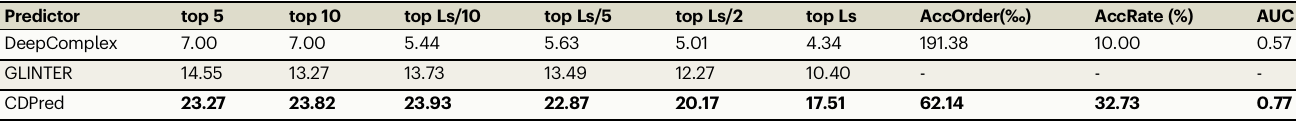
Table 4 | The evaluation of contact predictions on the HeteroTest2 test dataset for the DeepComplex, GLINTER, and CDPred